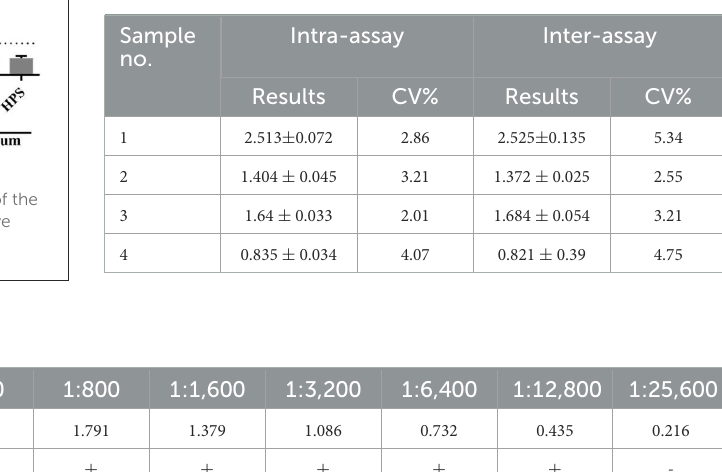
TABLE 4 Determination of repeatability by inter-assay and intra-assay.